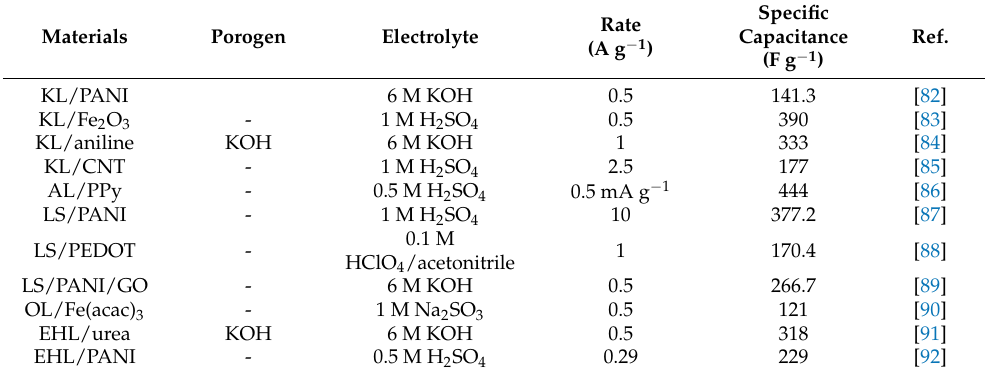
Table 5. Specific capacitance of composite lignin-based electrodes for